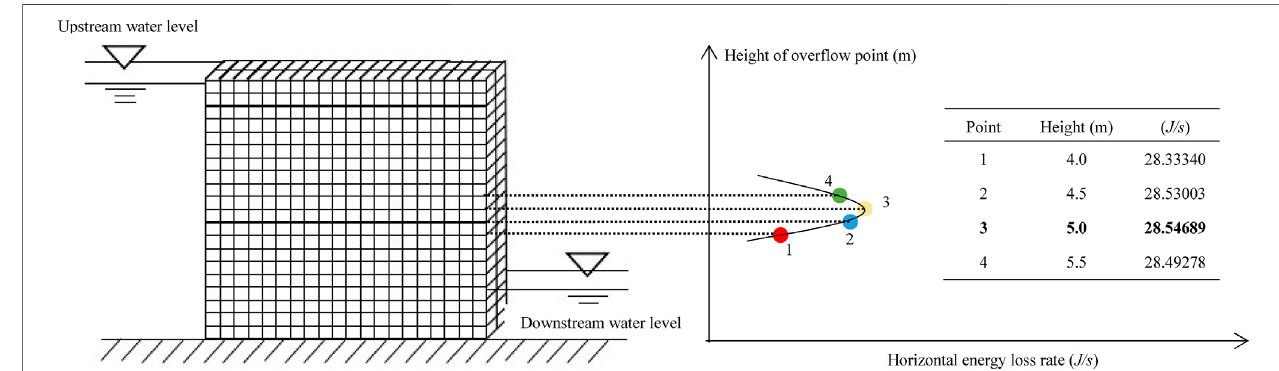
FIGURE 2 | Three-dimensional (3D) model division and calculation results of energy loss rate.